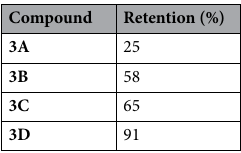
Table 1. Dye retention in silica nanoparticle vehicles.